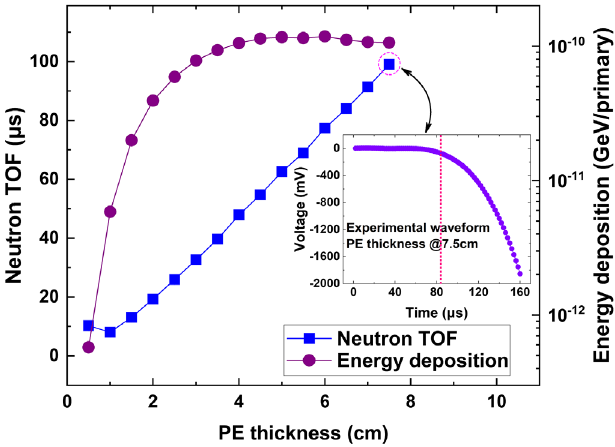
FIG. 31. The average neutron TOF and the energy deposition of BF 3 monitor with different PE thickness.